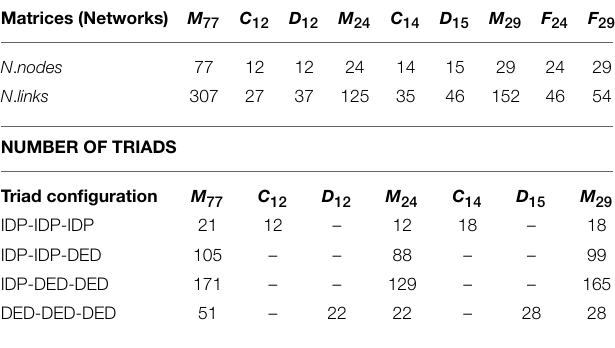
TABLE 1 | Number of nodes, links, and triads, with unspecified (directed or undirected) edges between indicated types of nodes, in the various networks represented by the various adjacency matrices of indicated